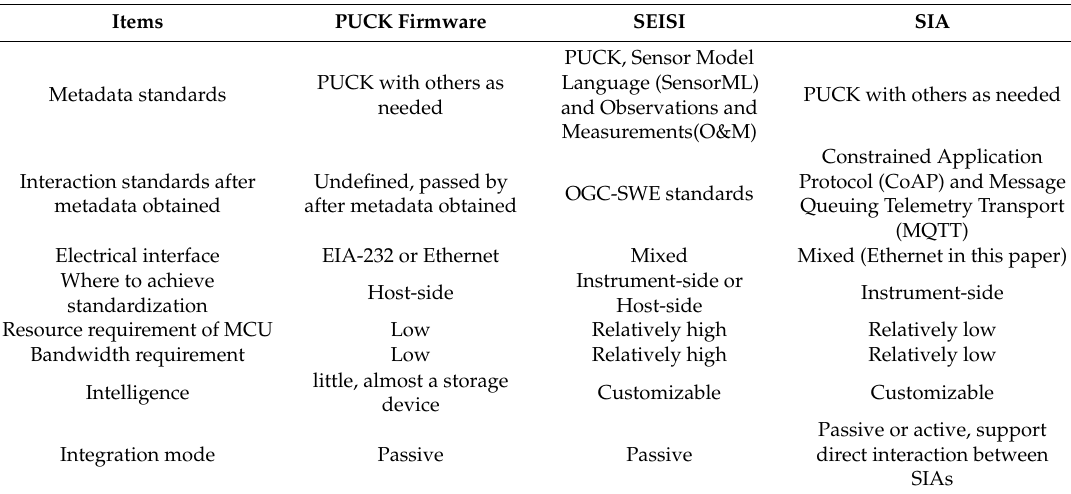
Table 1. Comparison of PUCK firmware, SEISI and SIA